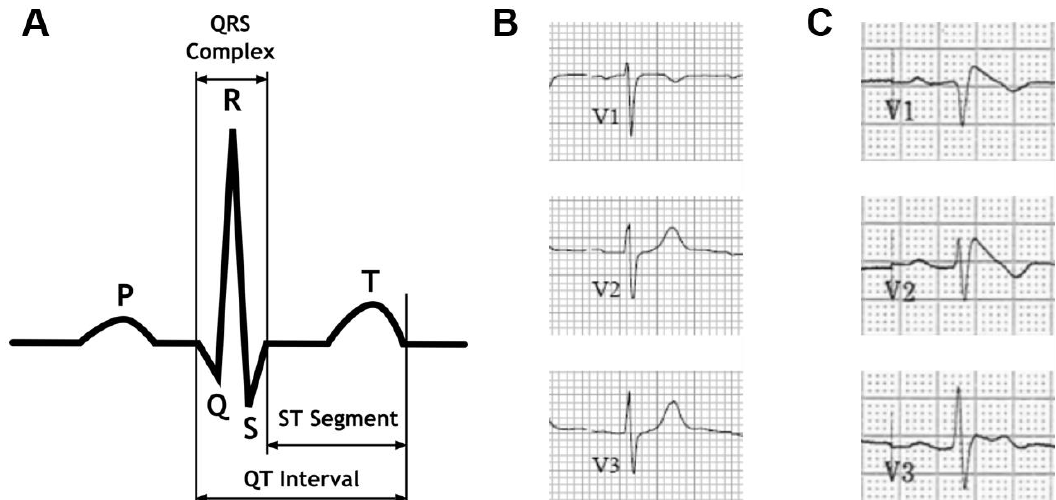
Figure 1. The electrocardiogram in the Brugada syndrome. ( A ) Schematic diagram of a normal electrocardiographic complex representing sinus rhythm. ( B ) Precordial leads V1-V3 from a normal electrocardiogram. ( C ) Precordial leads V1-V3 from a patient with Brugada syndrome.